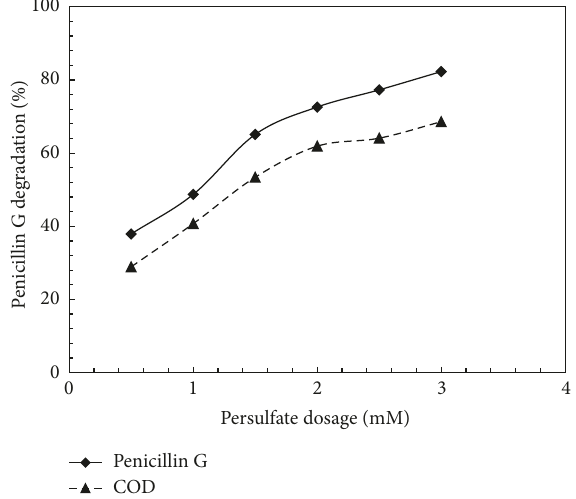
Figure 5: Effect of initial concentration of PG and reaction time on PG and COD degradation by processes of UV-activated persulfate, PS alone, and UV alone. Persulfate = 3 mM and pH =